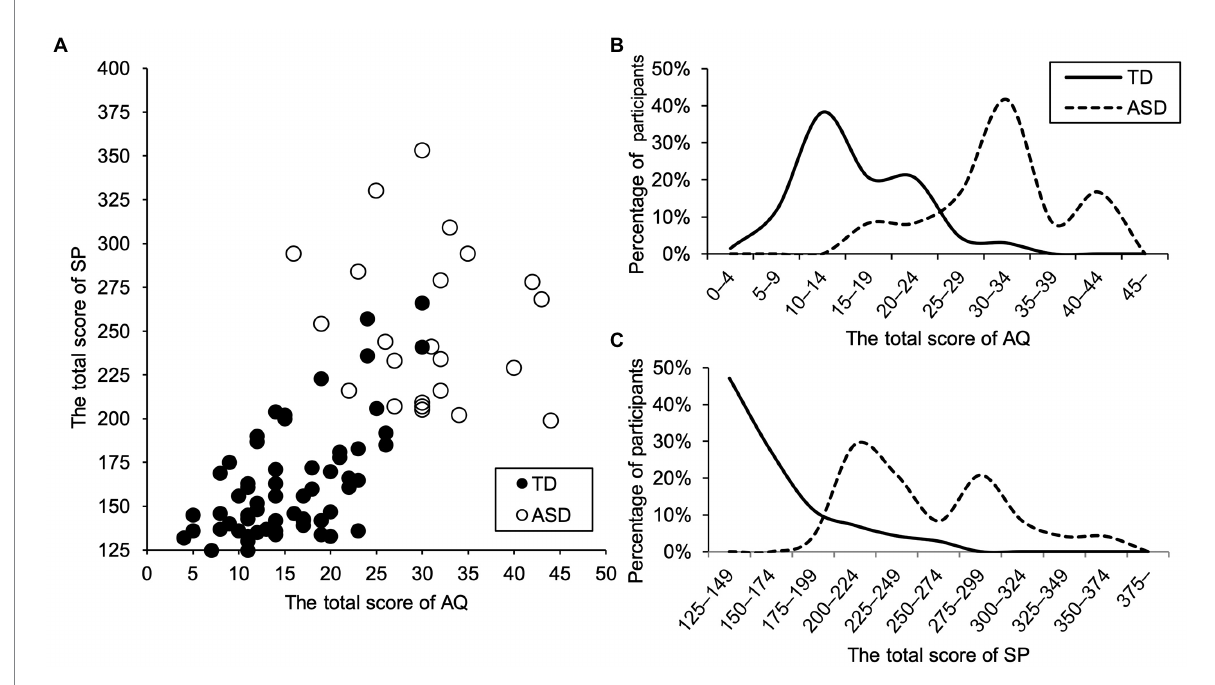
FIGURE 1 Frequency distribution (B and C) and scatter plot (A) of autistic traits and sensory symptoms in TD group ( n = 77) and ASD group ( n =